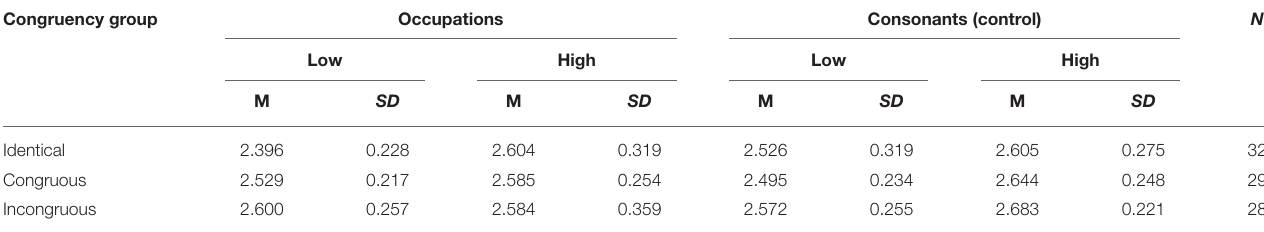
TABLE 1 | Mean income ratings (M) and standard deviations ( SD ) for each congruency group and each condition (faces consciously encoded with high- vs. low-wage occupations and unconsciously encoded with occupations vs. consonant strings). Congruency group Occupations Consonants